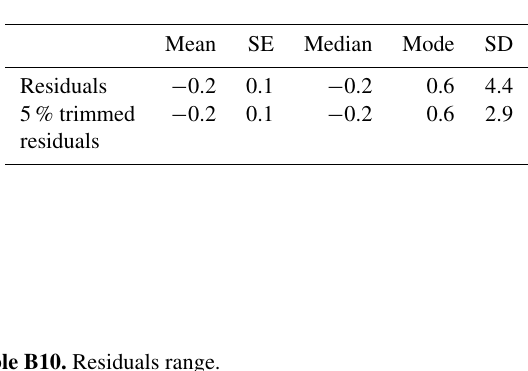
Table B9. Main descriptive statistics of residuals and 5% trimmed residuals.